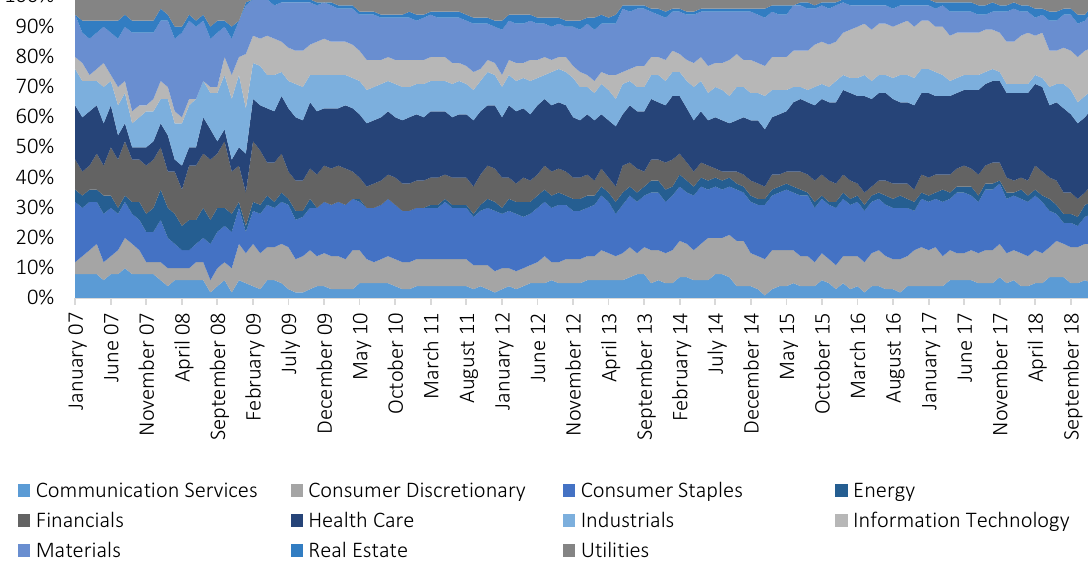
Communication Services